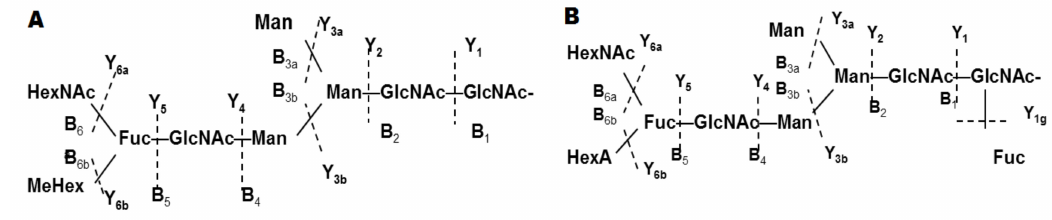
Figure 7. The complex structures presented for the ion at m / z 555.7 [M-3H] 3 − of RvH1 analyzed by CE-MS / MS and MS / MS spectra: ( A ) Structure presented by Giles et al. 2005 [11]; ( B ) Structure presented by Sandra et al. 2007 [33].